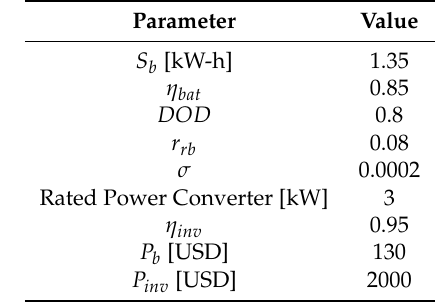
Table 5. Technical specifications of batteries and converter